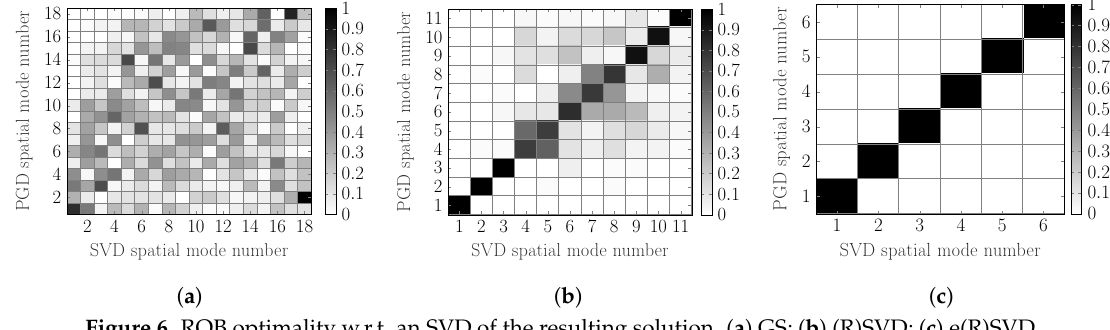
Figure 6. ROB optimality w.r.t. an SVD of the resulting solution. ( a ) GS; ( b ) (R)SVD; ( c ) e(R)SVD.